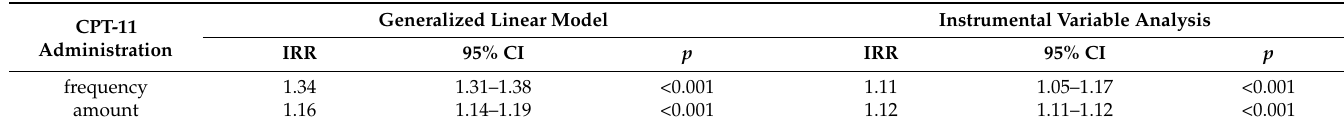
Table 3. Incidence rate ratios of CPT-11 administration with TJ-14 compared with without TJ-14 by generalized linear models and instrumental variable analyses.